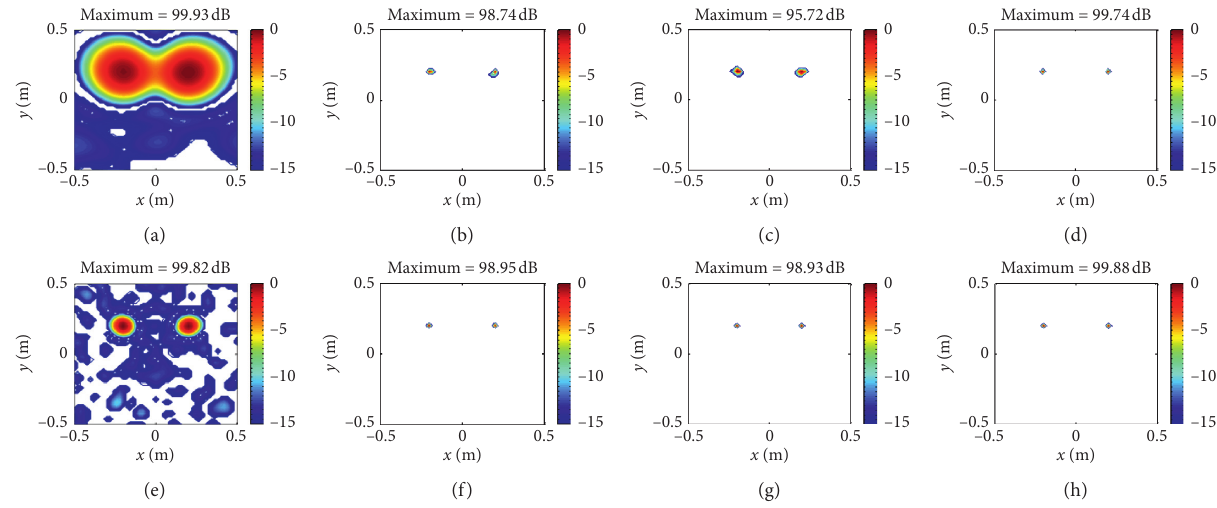
Figure 4: Contour maps of SPLs at 1 m distance from the source using different algorithms at a 20dB SNR. (a) CB at 2000Hz; (b) SC- DAMAS at 2000Hz; (c) FISTA at 2000Hz; (d) SFISTA at 2000Hz; (e) CB at 6000Hz; (f) SC-DAMAS at 6000Hz; (g) FISTA at 6000Hz; (h) SFISTA at